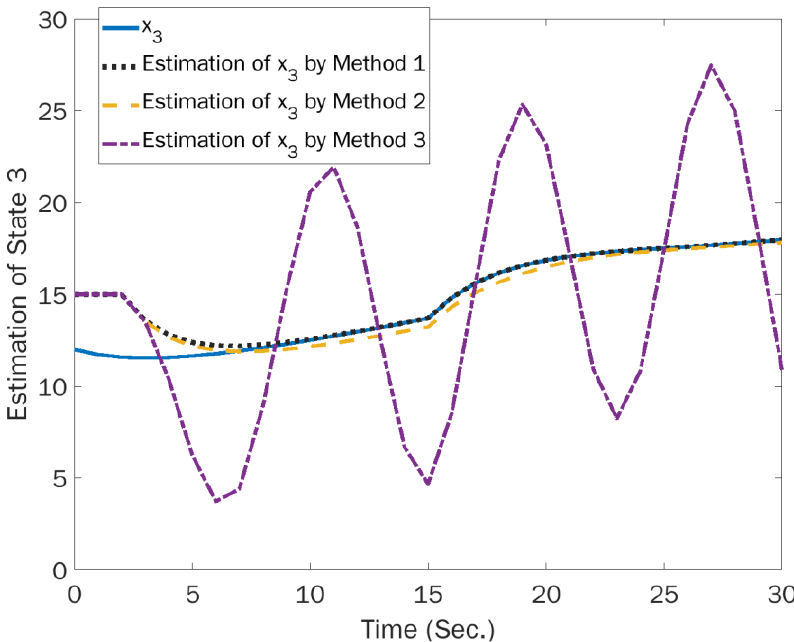
Figure 5. The state 3 estimation results of the three introduced observers.